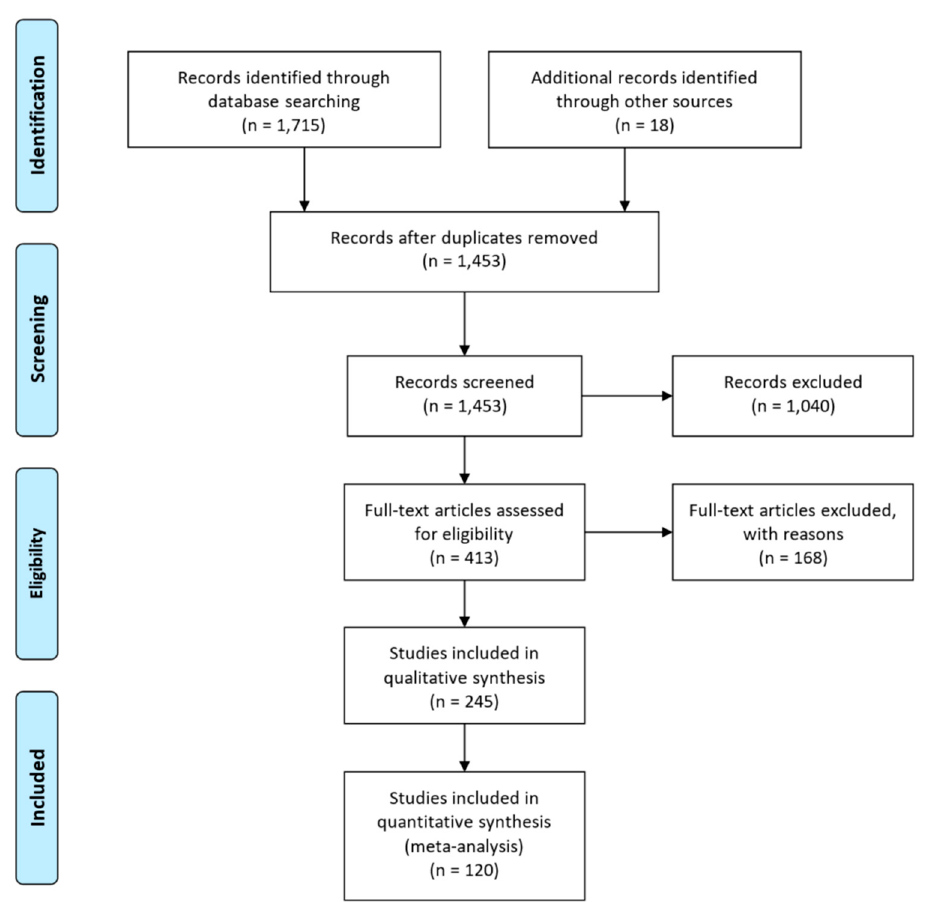
Figure 1. Search strategy steps as Preferred Reporting Items for Systematic Reviews and Meta-Analyses (PRISMA) flow diagram.